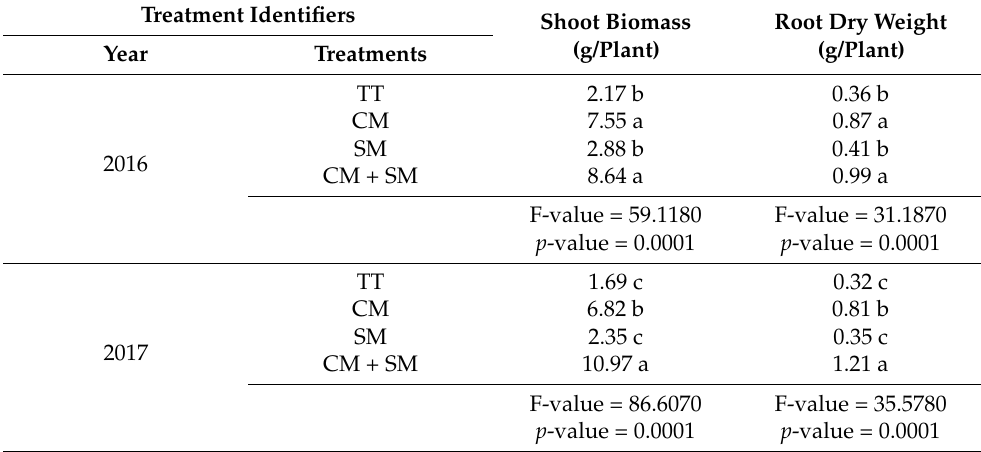
Table 4. Shoot biomass and root dry weight of maize at seeding stage for traditional tillage (TT), cattle manure mixing (CM), maize straw mulching (SM), and combined manure mixing and straw mulching (CM + SM) treatments during the cropping years. Means within a column in the same year followed by the same letter are not statistically different according to least significant difference test ( p = 0.05).